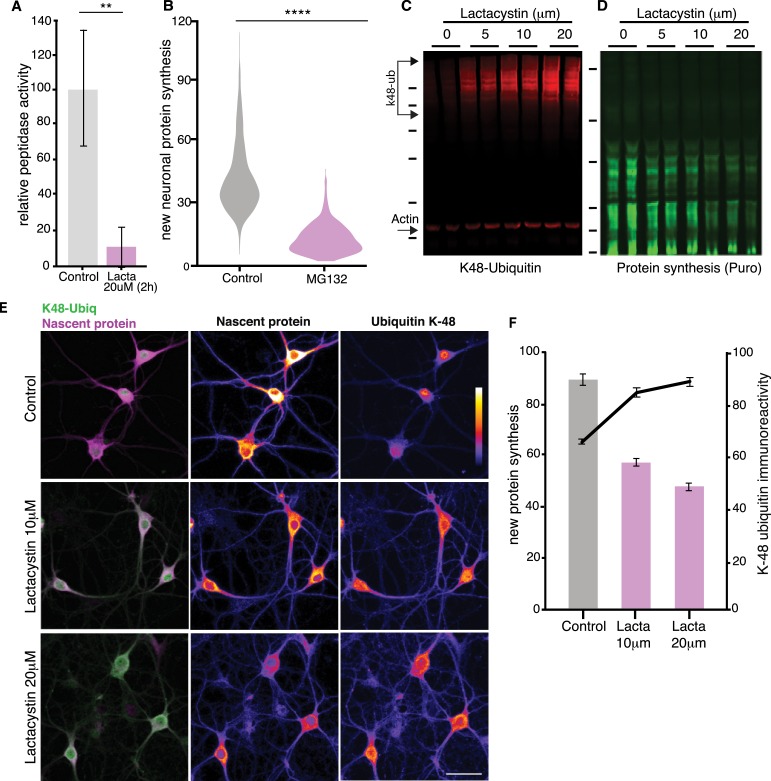
Additional experiments examining the effects of proteasomal inhibition on neuronal protein synthesis.(A) Proteasome peptidase kinetic activity assay showing that a 2 hr Lactacystin treatment inhibits the proteasome by ~80% (unpaired t-test, p≤0.01, control, treated, kinetic slopes are represented, see Materials and methods, two experiments). (B) Analysis of experiments shown in Figure 1E. Protein synthesis in hippocampal neurons was reduced by over 30% following proteasome inhibition. (p<0.0001, unpaired t-test, ctrl n = 1768, PI n = 1137 neurons, five experiments, two dishes per experiment and condition). (C) Representative western blot of K48 ubiquitin chains. Shown are two biological replicates from a control sample and neurons treated with increasing concentrations of lactacystin (2 hr treatment). Actin is shown as a loading control. Molecular weight markers from top-to-bottom are 250, 150, 100, 75, 50, and 37 kD. (D) Representative western blot of puromycylated newly synthesized proteins (the same membrane shown in C was incubated with an anti-puromycin antibody). Note that the increasing K48-ubiquitin signal (C) is paralleled by a decrease in puromycin signal. Molecular weight markers from top-to-bottom are 75, 50, 37, 25, 20, 15 kD. (E) Metabolic labeling (using puromycylation, see Materials and methods) of the global nascent protein pool and K48-ubiquitin chains in hippocampal cell bodies and dendrites following proteasome inhibition using increasing concentrations of lactacystin (2 hr treatment). In the first column the merged channels for K48-ubiquitin (green) and puromycin (magenta) are shown, followed by color-lookup images for individual channels. Scale bar = 50 μm. (F) Analysis of experiments shown in E. (unpaired t-test, for protein synthesis; control vs 10 μM lactacystin, p≤0.0001, control vs 20 μM lactacystin, p≤0.0001, for k48-ubiquitin; control vs 10 μM lactacystin, p≤0.0001, control vs 20 μM lactacystin, p≤0.0001, control n = 316, lacta 10 μM n = 394, lacta 20 μM n = 378 neurons, three experiments). Error bars = SEM.Figure 1—figure supplement 1—source data 1.Source data for Figure 1—figure supplement 1A, B, F.Figure 1—figure supplement 1—source data 2.Source data for Figure 1—figure supplement 1C, D.